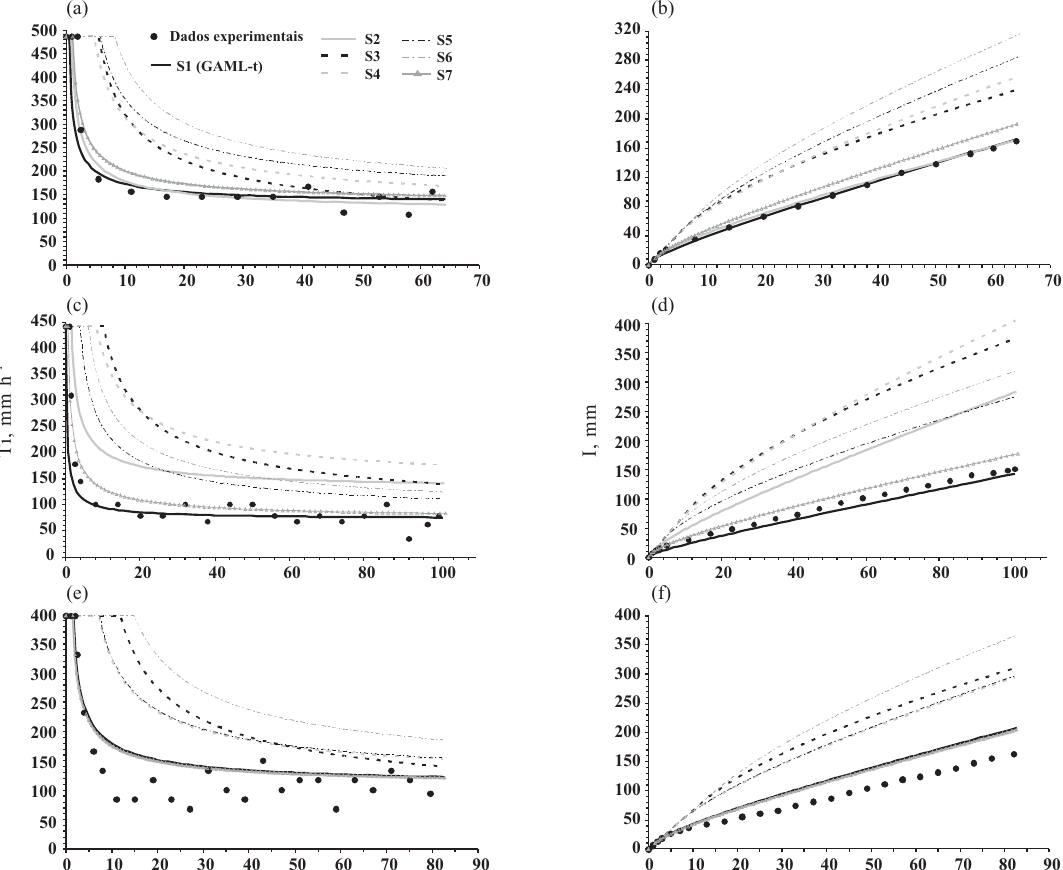
Figura 1. Taxas de infiltração (a), (c) e (e) e lâminas infiltradas (b), (d) e (f) medidas e estimadas para os três testes experimentais realizados no